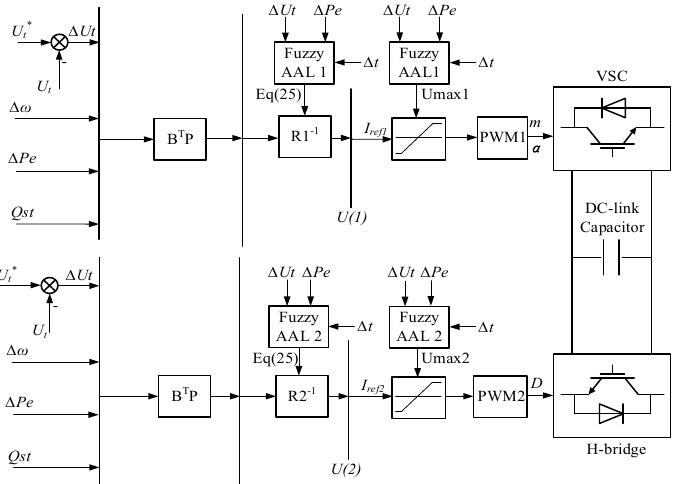
Figure 5. Coordinated control strategy based on decoupling control of stator and rotor.